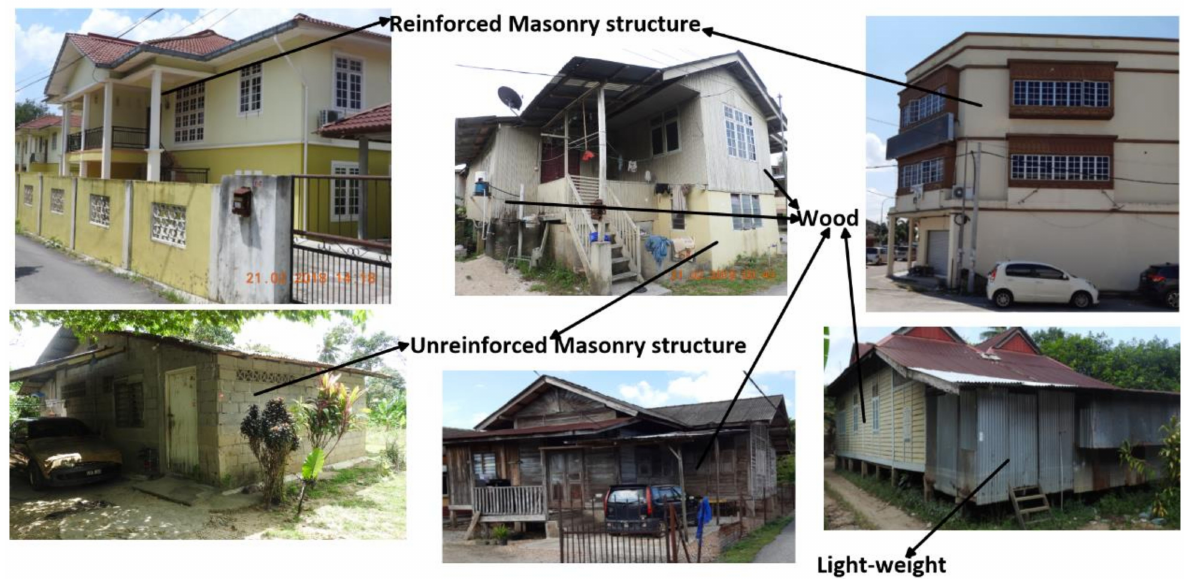
Figure 12. Examples of different building construction type and materials in Kota Bharu,